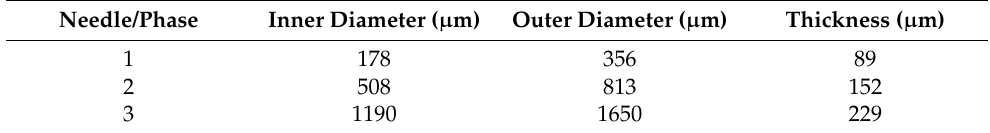
Table 1. The dimensions of the tri-axial needles.